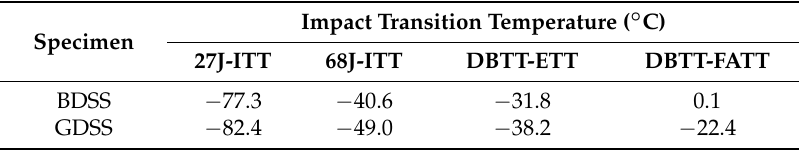
Table 4. Impact transition temperatures calculated from Charpy impact tests on the SDSSs.